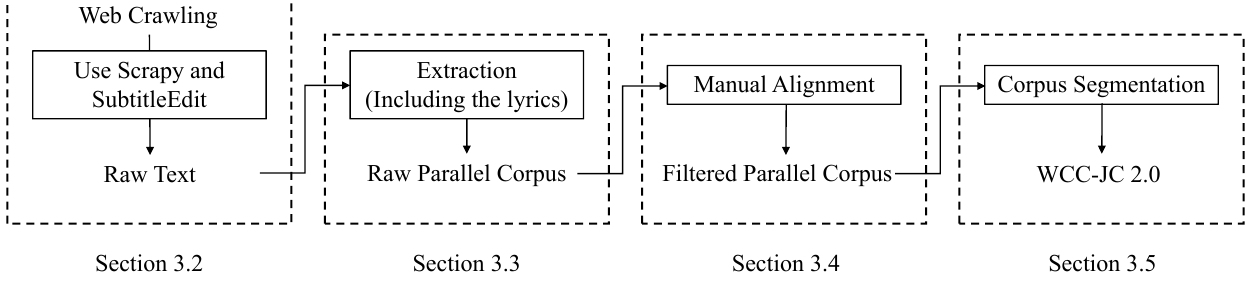
Figure 2. The main steps to build the corpus from the raw subtitle